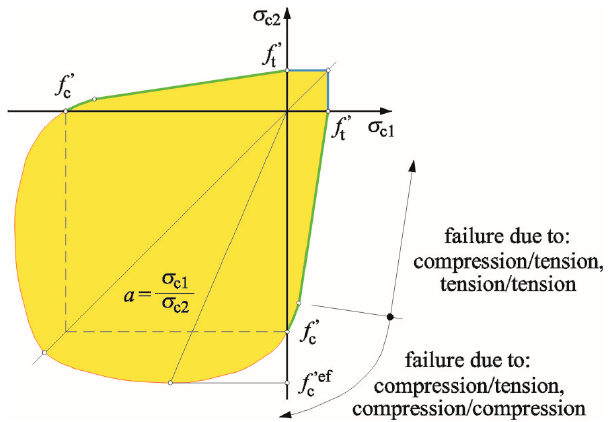
Figure 5. Failure criterion for material under biaxial stress state on the basis of [46]. Under biaxial tensile stress, tensile strength was constant and equal to material strength and (cid:48) uniaxial tensile force f . For elastic material with degradation, the model of smeared cracks developing t in a uniform direction was applied. The crack was assumed to develop towards main strains ε 1 , with ε 1 = ε t corresponding to tensile strength. The direction of crack development did not change during further loading. Table 3 presents material parameters for concrete in confining elements and tie beams, used for numerical